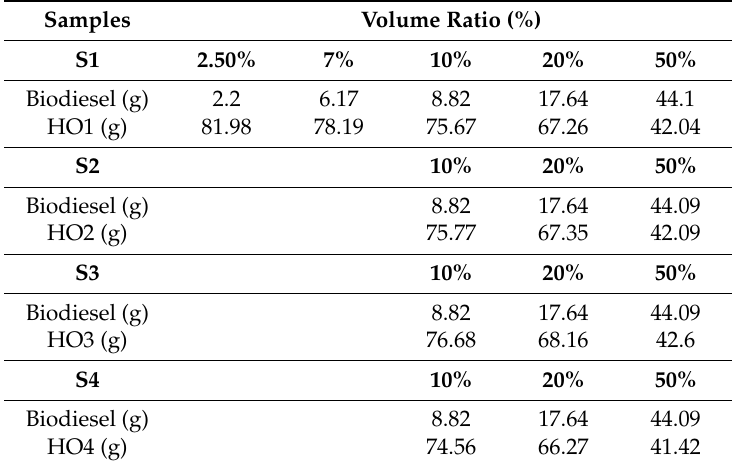
Table 2. Preparation of mixtures by volume ratio of biodiesel with heating